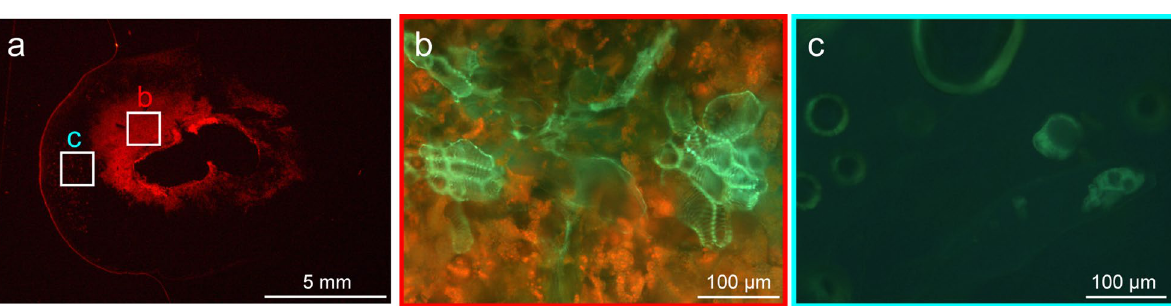
Figure 4. Internal structure of the mature gall. Autofluorescence of chlorophylls (red) and lignin (green). ( a ) sagittal section of the whole gall, ( b ) magnified image of the inner areas, and ( c ) magnified image of the outer